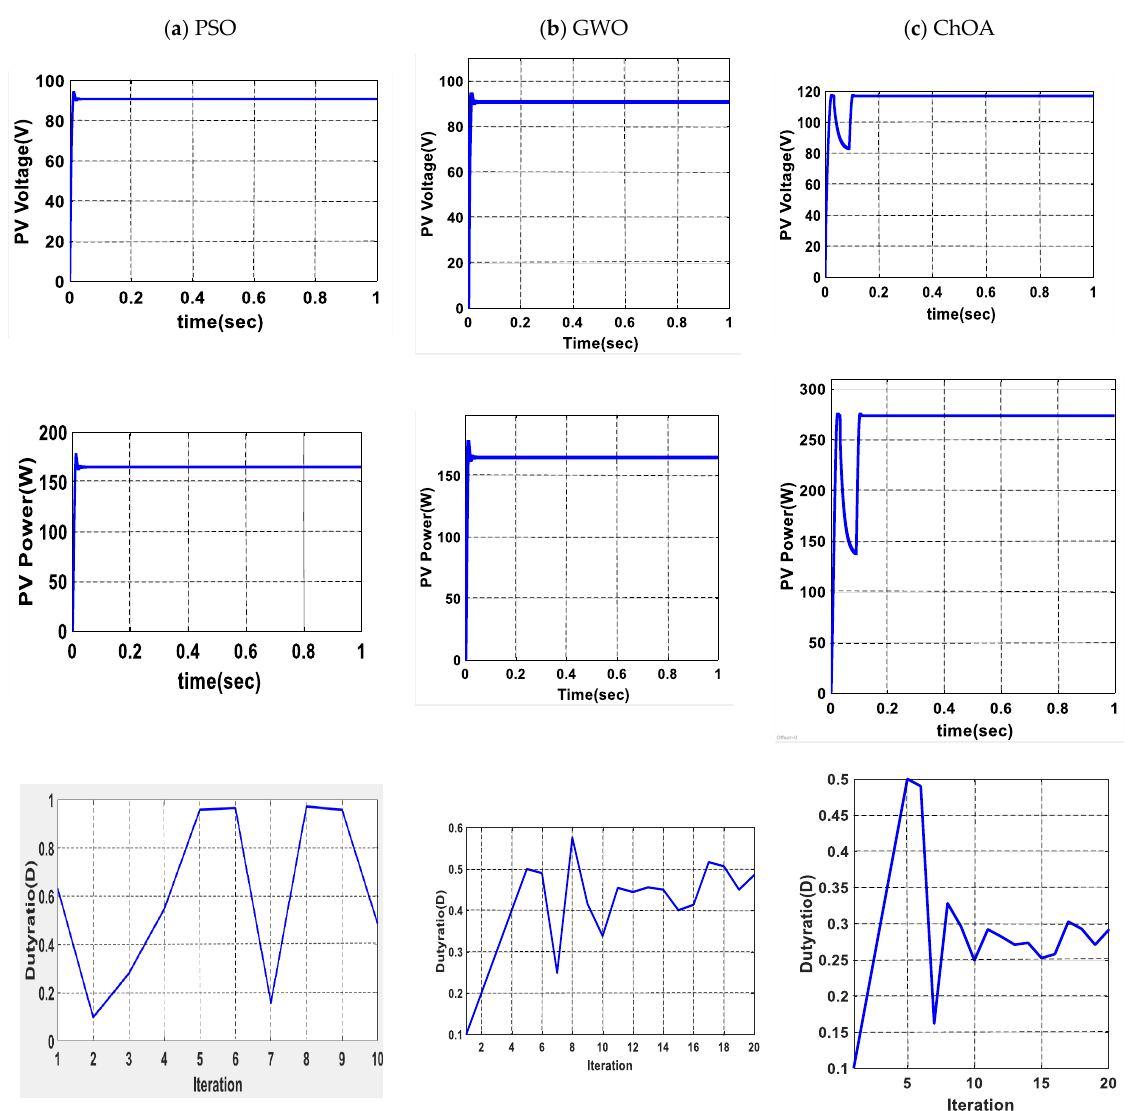
Figure 12. Precise simulation results of PV strings for shading pattern of 800 W/m 2 , 600 W/m 2 , 400 W/m 2 , 200 W/m 2 proposed technique, PSO and the conventional P&O technique for weak shading pattern: ( a ) PSO technique ( b ) GWO technique ( c ) ChOA technique.